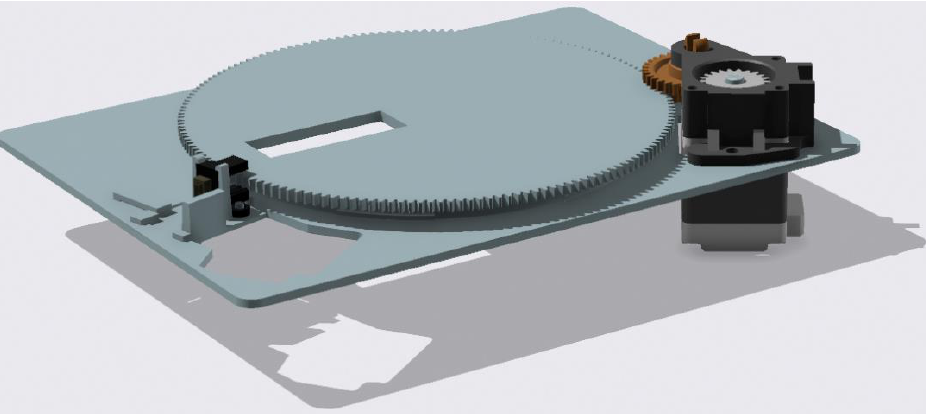
Figure 5. Render of the gearbox assembly, which has different gears and components which require several manual steps to be assembled.